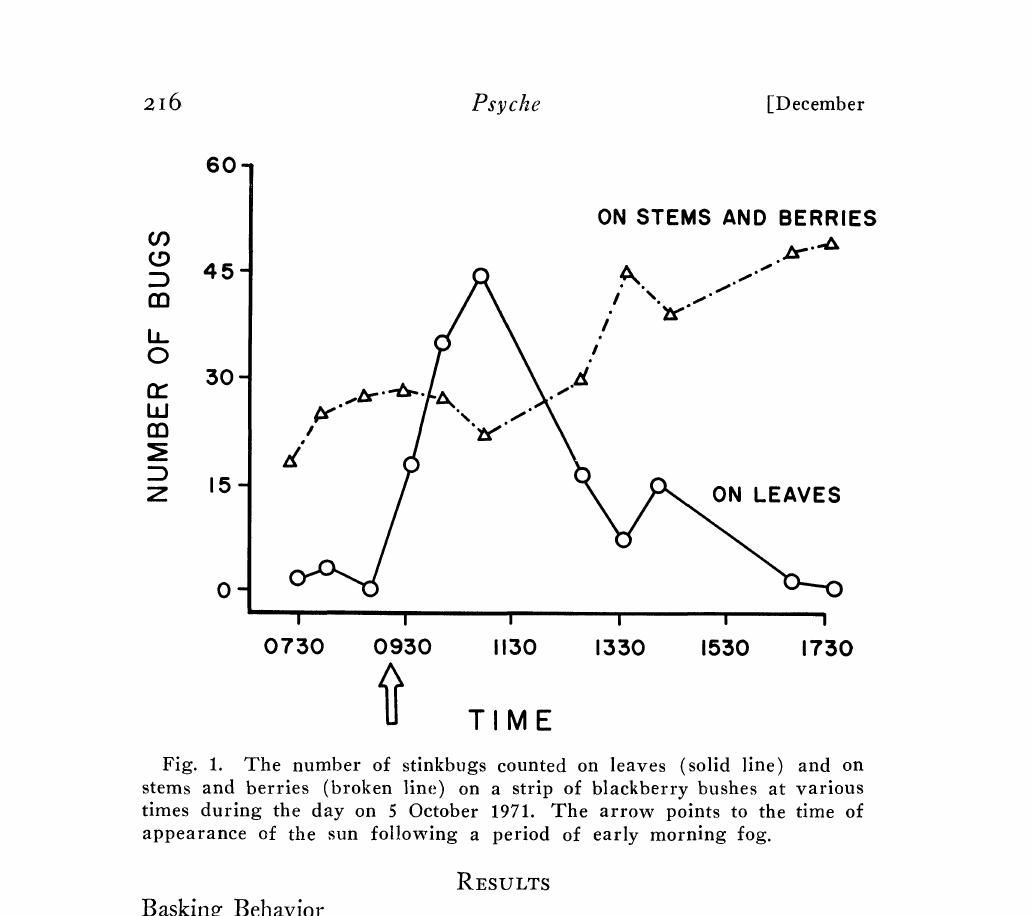
Fig. 1. The number of stinkbugs counted on leaves (solid line) and on stems and berries (broken line) on a strip of blackberry bushes at various times during the day on October 1971. The arrow points to the time of appearance of the sun following a period of early morning